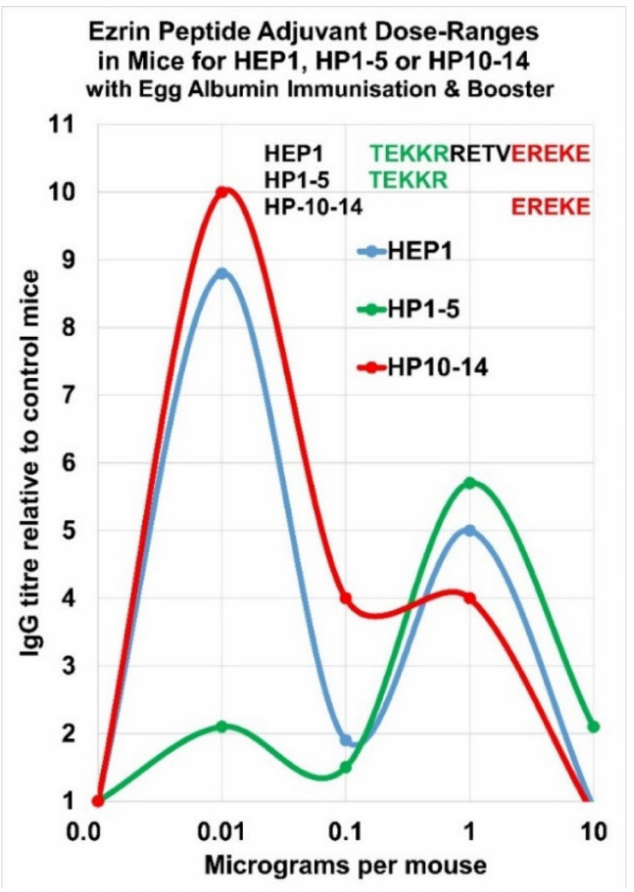
Figure 12. The two separate peaks of adjuvant activity were observed in mice i/p-injected with HEP1 or with ezrin peptide fragment HP1–5 TEKKR or with ezrin peptide fragment HP10–14 EREKE, and simultaneously immunised then boosted with 50 µ g of soluble heterologous egg albumin EA antigen, to produce serum IgG antibodies. The immune response 7 days after immunisation and booster with EA antigen was expressed relative to the ELISA IgG titre in control mice, which had received injections of EA only, plotted by